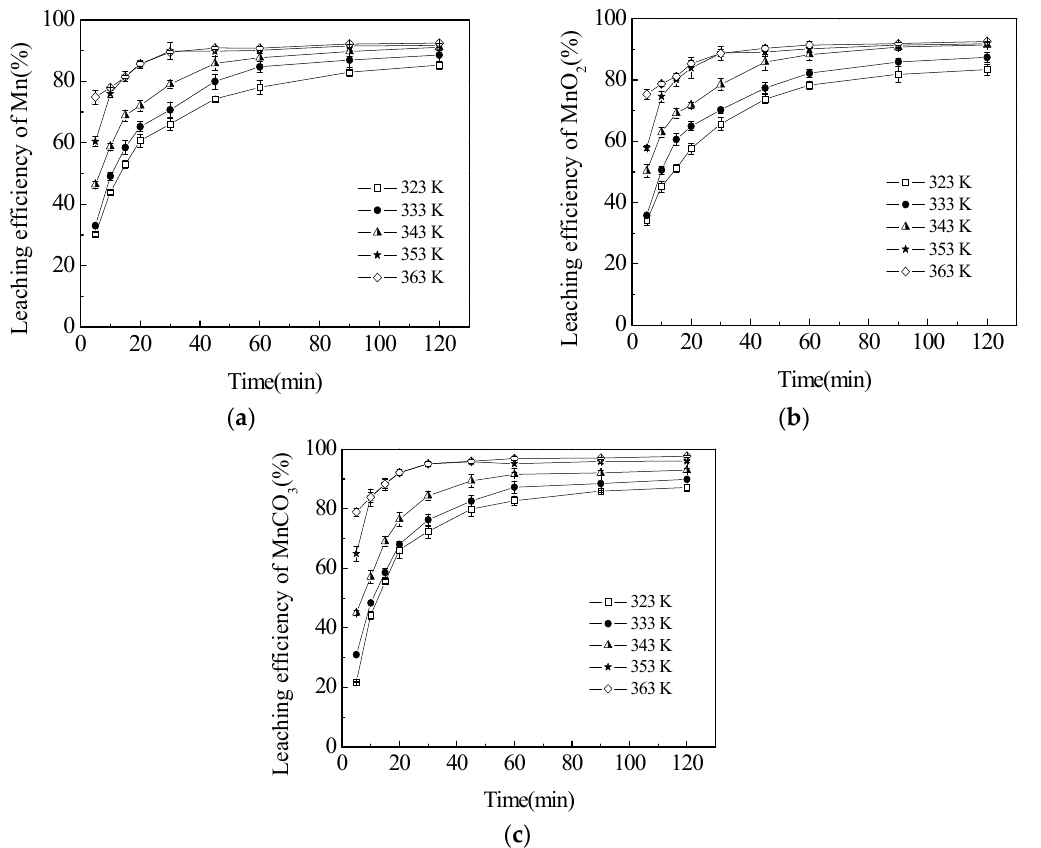
Figure 5. Effect of the reaction temperature on the leaching efficiencies of TMn ( a ); MnO 2 ( b ); and MnCO 3 ( c ) in semi-oxidized manganese ore. The data points represent the average values from the triplicate experiments and the error bars represent the 95% Cls.